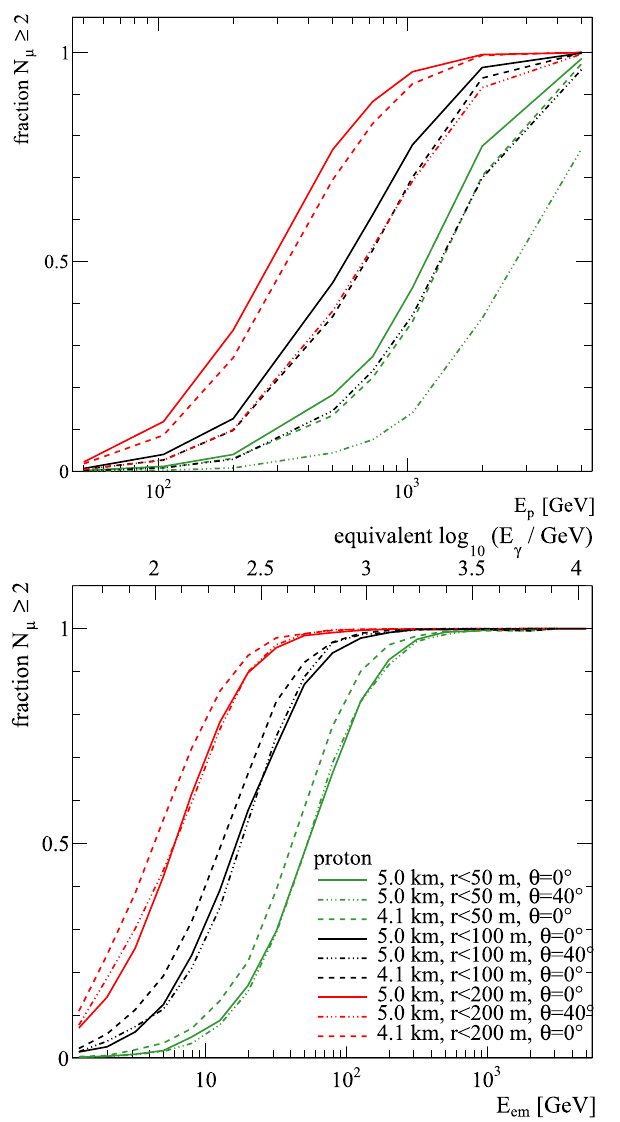
Fig. 11 Top: fraction of proton induced showers that have more than two muons within 50/100/200 m distance of the shower EM barycentre as a function of primary particle energy. Bottom: the same fraction but as a function of the electromagnetic energy brought to the ground ( E em ). The upper label for the abscissa indicates the average energy of a vertical incoming γ -ray primary which results in the same E em as observed at 5 km altitude. The 4.1km above sea level corresponds to the altitude of the HAWC observatory